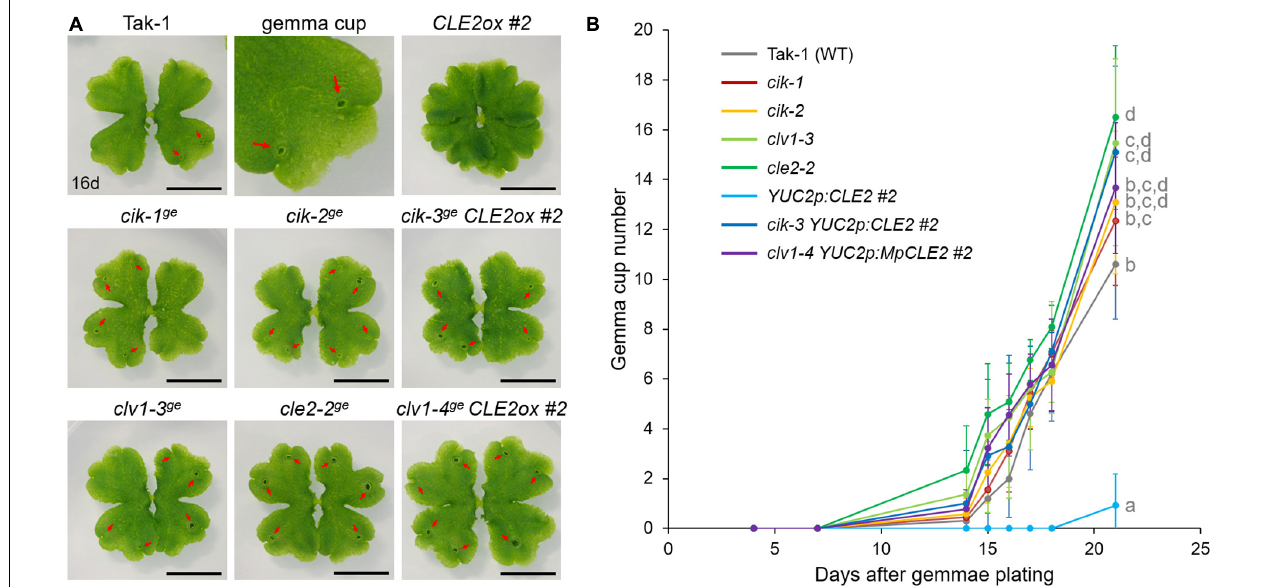
FIGURE 3 | Mp CIK knockout suppresses gain-of-function phenotypes of Mp CLE2. (A) Overall morphology of 16-day-old plants grown from gemmae. Genotypes are indicated above the panels. The upper middle panel shows the magnification of Tak-1 image. Note that pro Mp YUC2: Mp CLE2 ( CLE2ox ) exhibits multichotomy and produces no gemmae cups at this age while cle2 , clv1 , and cik loss-of-function alleles form more gemma cups compared to Tak-1. Arrows indicate gemma cups. Scale bars represent 1 cm. (B) Number of gemmae cups (mean and SD; n = 9–12). Data are obtained at 4, 7, 14, 15, 16, 17, 18, and 21 days after gemmae plating. Data of 21-day-old plants sharing the superscripts are not significantly different from each other in Tukey’s HSD test, p < 0.05. This experiment was repeated twice with similar results.